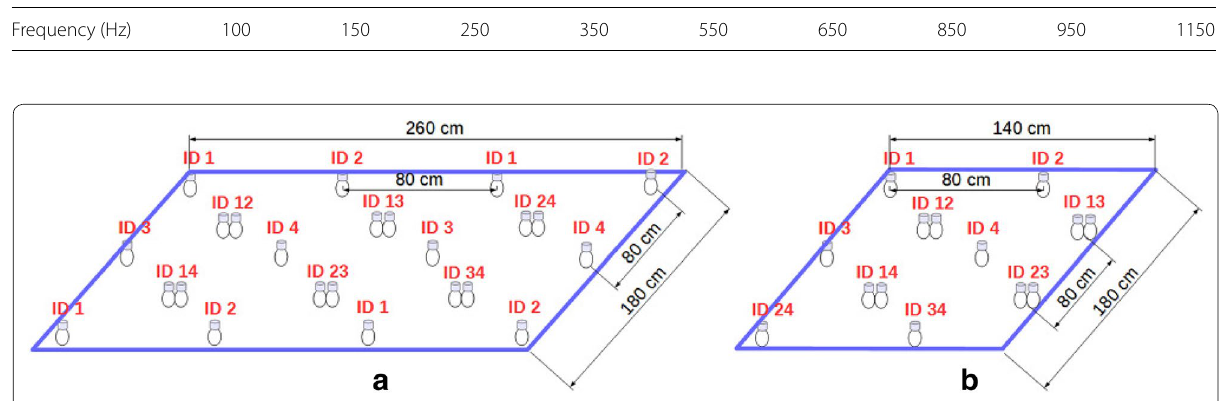
Fig. 3 Scale of environments in which the two different configurations are used. a Scale when combining unique ID encoding emitters with repeated ID encoding emitters; b scale when using unique ID encoding emitters